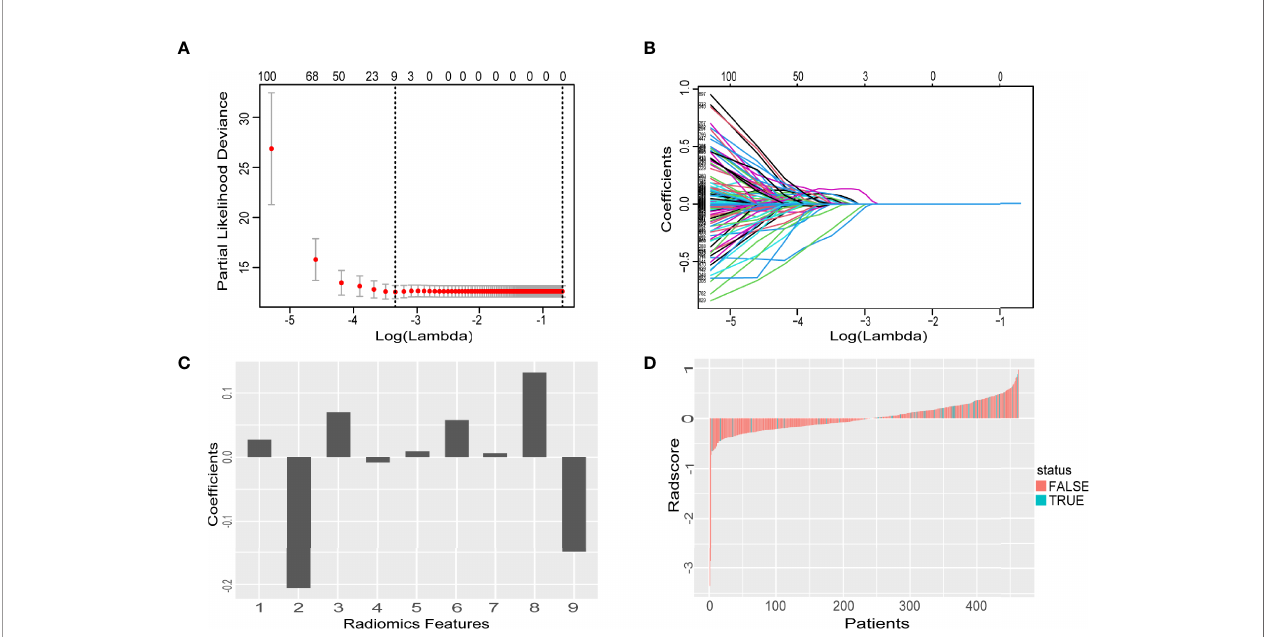
FIGURE 2 | Radiomics feature selection using the LASSO algorithm. (A) Used the 1O-fold cross validation to identify the optimal penalization coef fi cient lambda the minimum was 0.000577, with log ( l ) = -3.238. (B) The model coef fi cient trendlines of radiomics features. (C) The histogram of coef fi cients with 9 features. (D) Rad- score for each patient. Red bars show scores for patients who survived without progression, while blue bars show scores for patients who happened progression, metastasis or